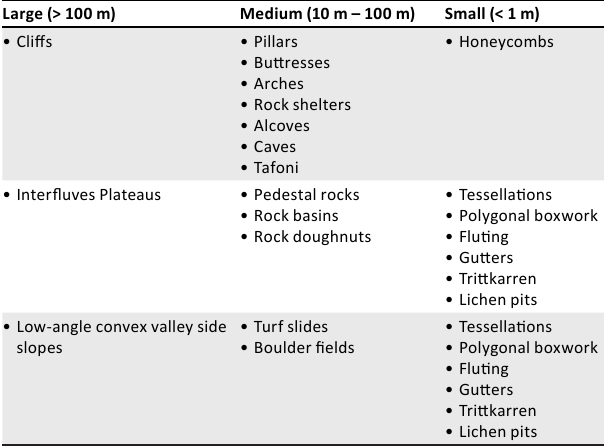
TABLE 1: A scale hierarchy of sandstone landforms in the Golden Gate Highlands National Park.